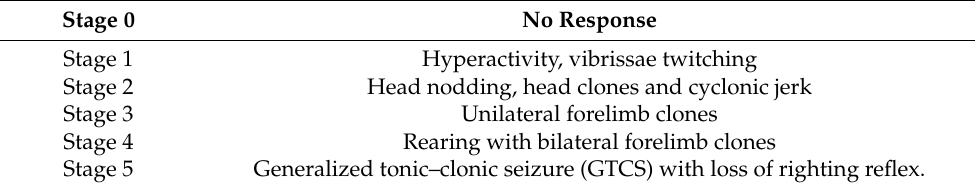
Table 1. Scoring system for seizure activity (Racine